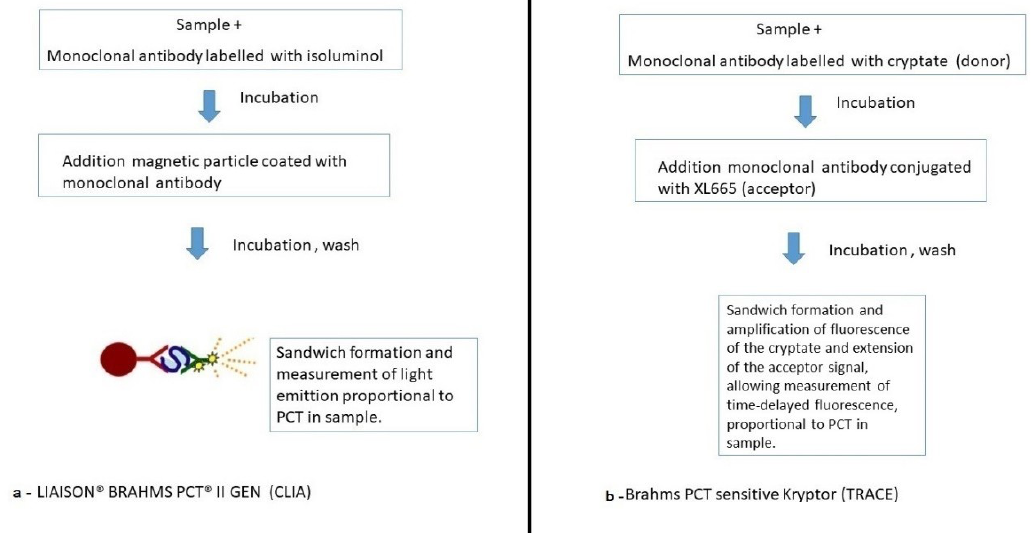
Figure 1. ( a ) Liaison Brahms PCT II Gen and ( b ) Brahms PCT sensitive Kryptor immunofluorescence test mechanism.